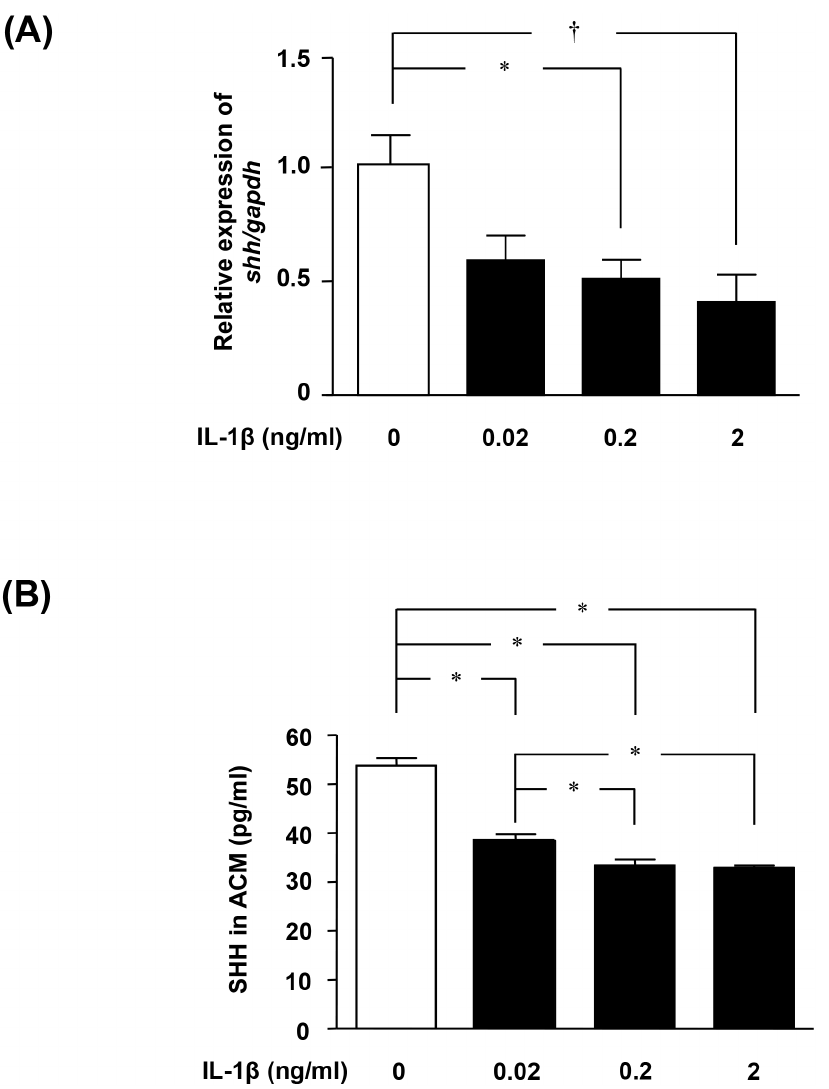
Figure 2. IL-1 b downregulates SHH production in astrocytes. (A) Shh mRNA levels in astrocytes, determined by qPCR. Astrocytes were treated with IL-1 b for 6 h. Values are means 6 SEM (n=5). *, p , 0.05; { , p , 0.01. (B) Protein levels of SHH in ACM, determined using ELISA. Astrocytes were treated with IL-1 b for 24 h. Values are means 6 SEM (n=5). *, p , 0.001.